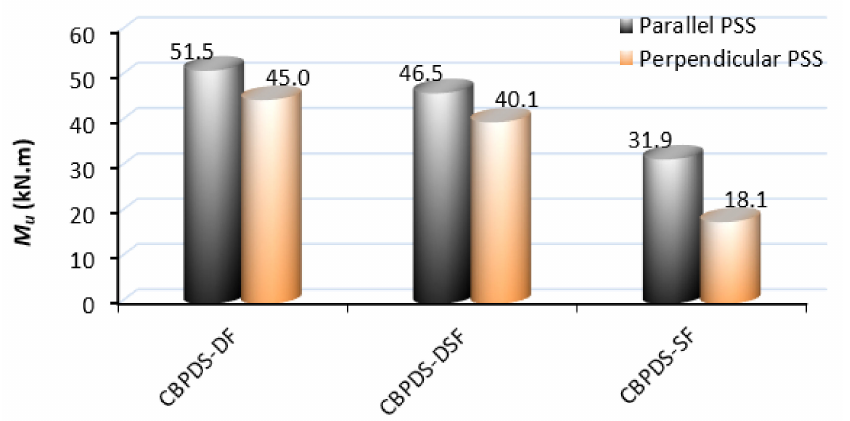
Figure 18. Ultimate moment capacity of CBPDS